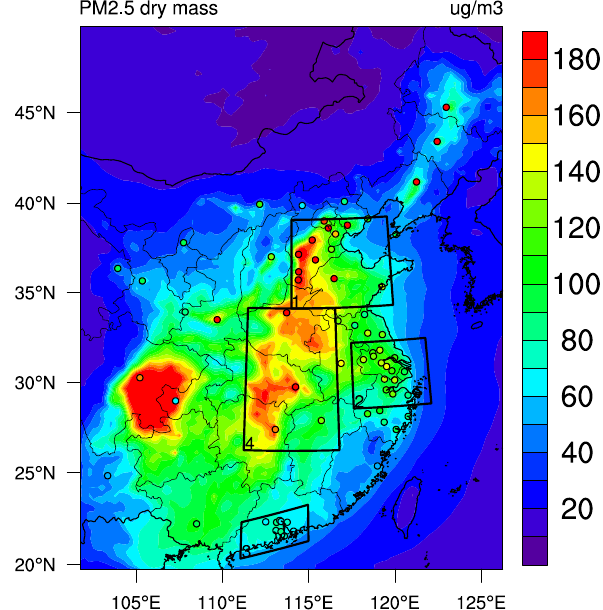
Figure 4. Simulated and observed (circles) monthly mean PM 2 . 5 mass concentration over eastern China in January 2013. The four polygons correspond to the North China Plain (NCP) (1), the Yangtze River delta (YRD) (2), the Pearl River delta (PRD) (3), and central China